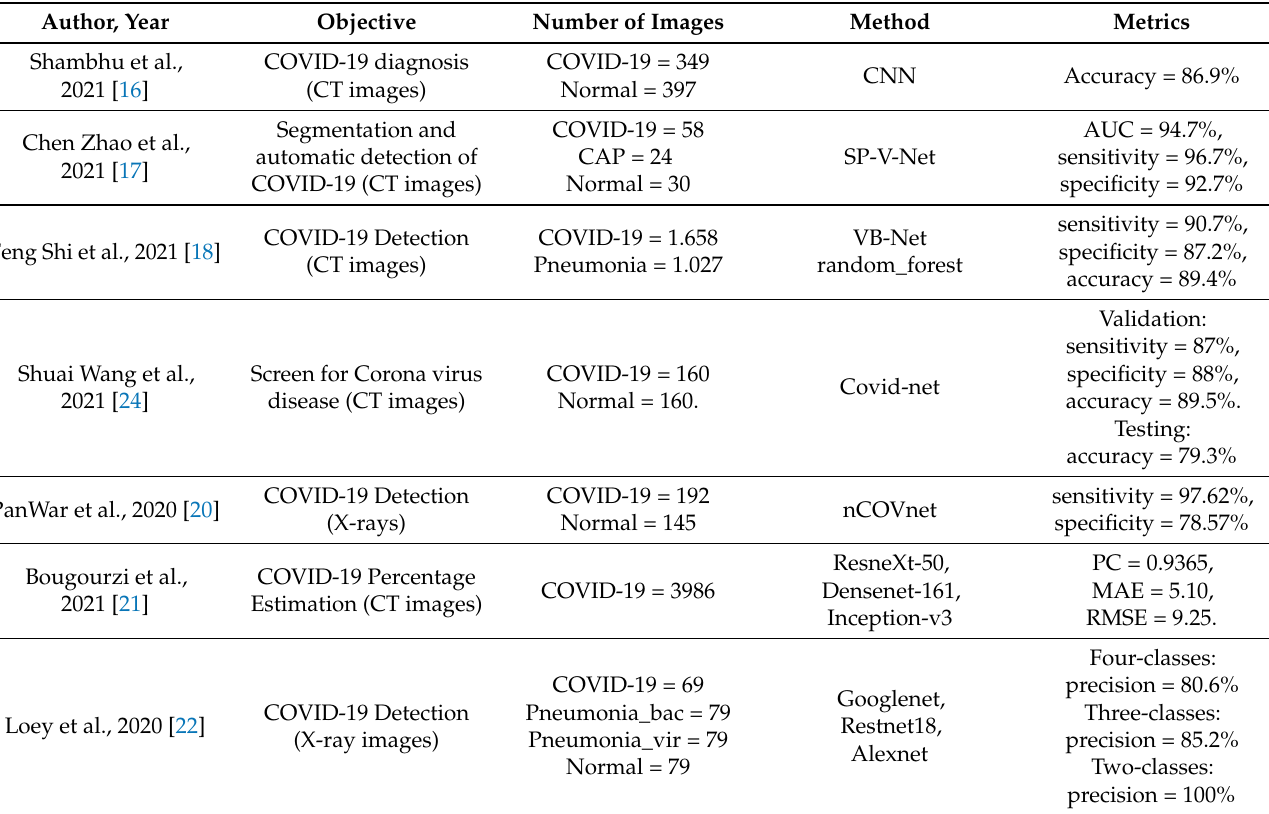
Table 1. Comparative summary of different methodologies presented in the